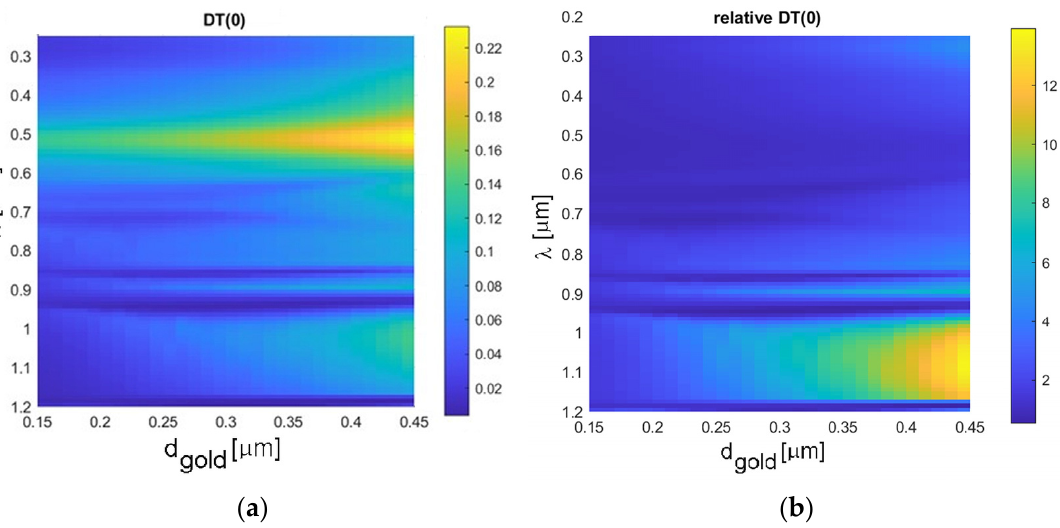
Figure 4. Contour graphs of spectral transmittance calculated by the FMM method for the 2D regular rectangular plasmonic holes array (with the same translation parameters as used in Figure 3), as a function of the gold layer thickness (d gold ) and wavelength ( λ ), referred to BK-7 glass slide ( a ) and continuous Au/Cr/Bk-7 slab ( b ).